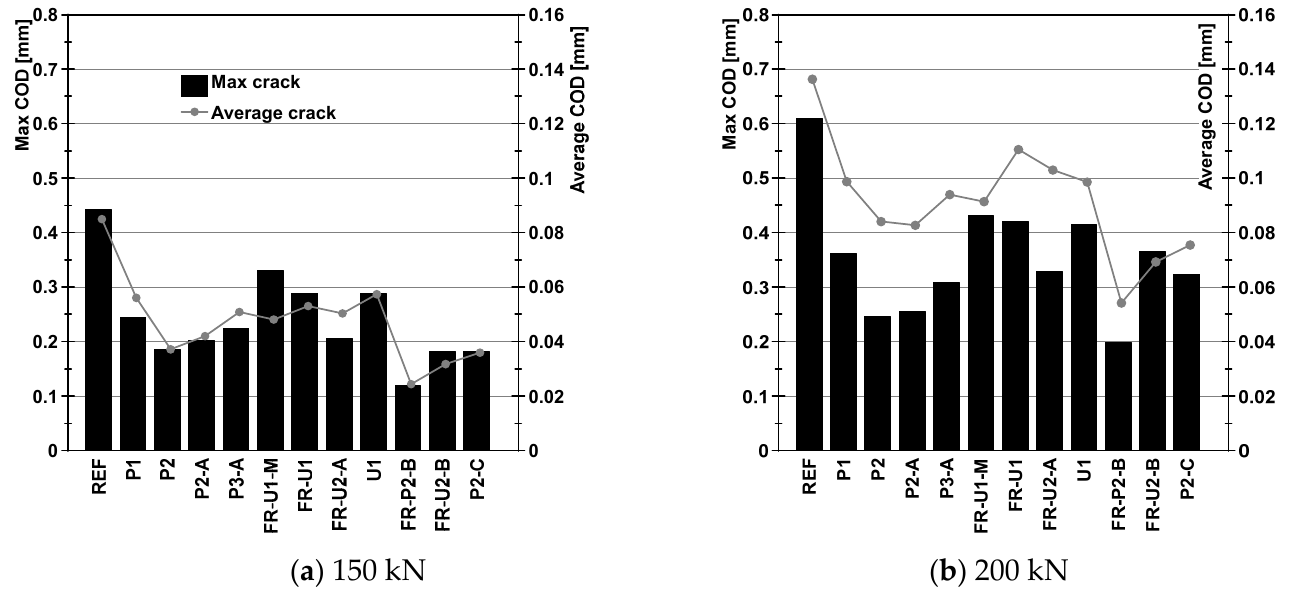
Figure 10. Maximum and average crack opening at reference loads.